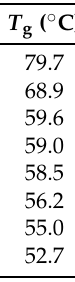
Table 2. Glass transition temperature of 8 types of PU (PU0–PU15 are types of PU and PU6—PU which contain 6%